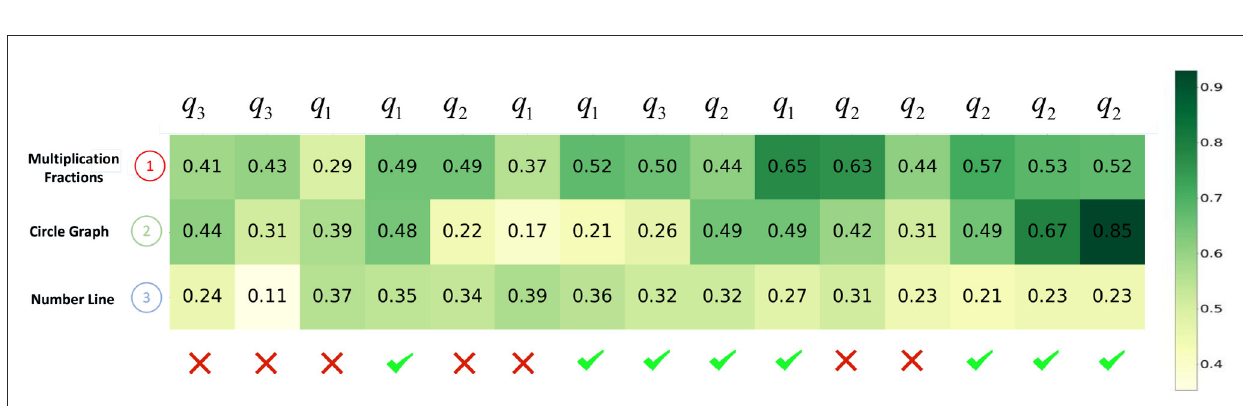
FIGURE9 The evolution of predicted knowledge states produced by DKT. The y-axis represents the knowledge concepts, and the x-axis represents the student’s responses to a sequence of the questions. The grids represent the predicted knowledge states, i.e., the predicted probabilities that the student has mastered the knowledge